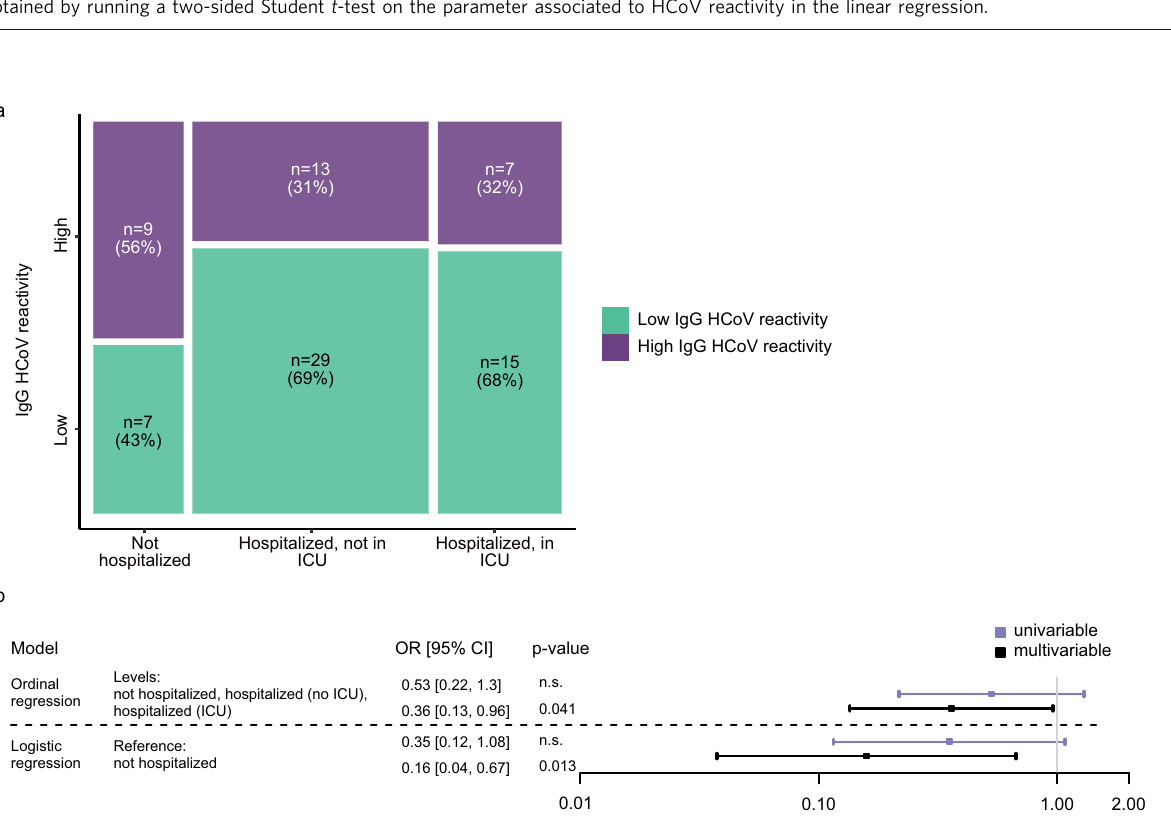
Table 12). Sources, speci fi cs and concentration of detection and control antibodies and sera used for ABCORA and neutralization tests are listed in Supplementary Table 13. 293-T cells were obtained from the American Type Culture Collection (ATCC CRL-11268) 55 . HT1080/ACE2cl.14 cells 33 were kindly provided by P.